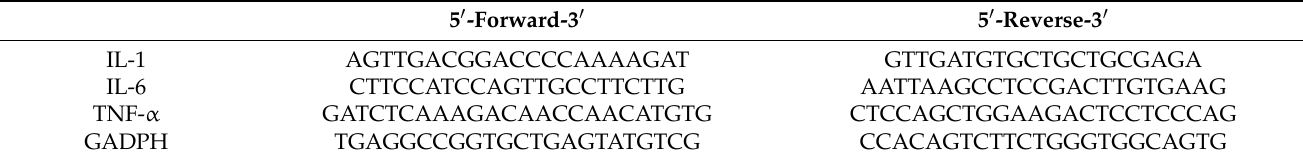
Table 2. Forward and reverse primers of GADPH, IL-1, IL-6 and TNF- α that were used for RT-PCR. 5 (cid:48) -Forward-3